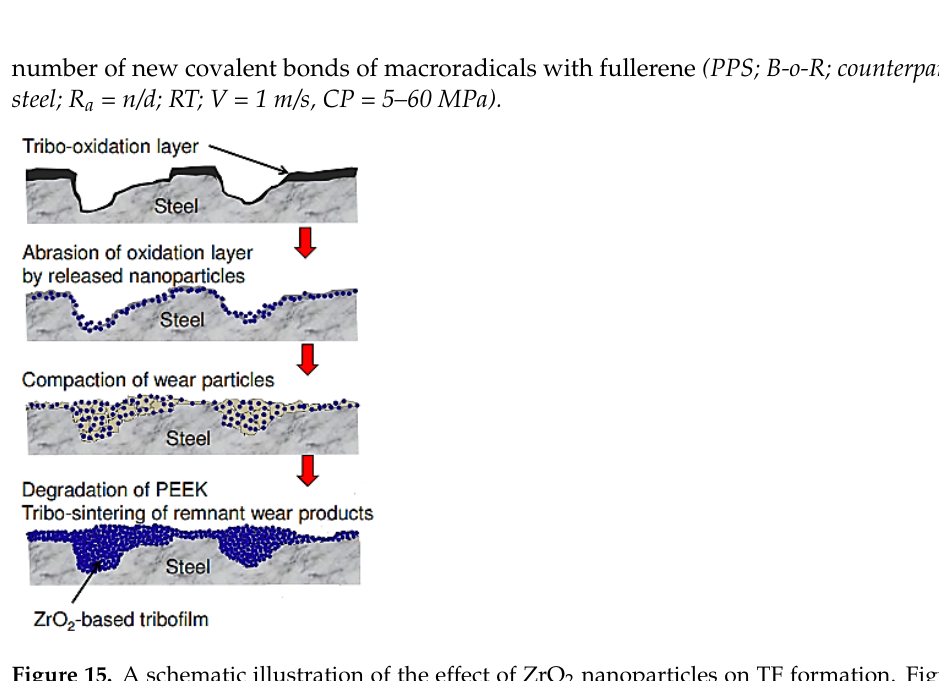
Figure 15. A schematic illustration of the effect of ZrO 2 nanoparticles on TF formation. Figure is reproduced with permission from reference [100].